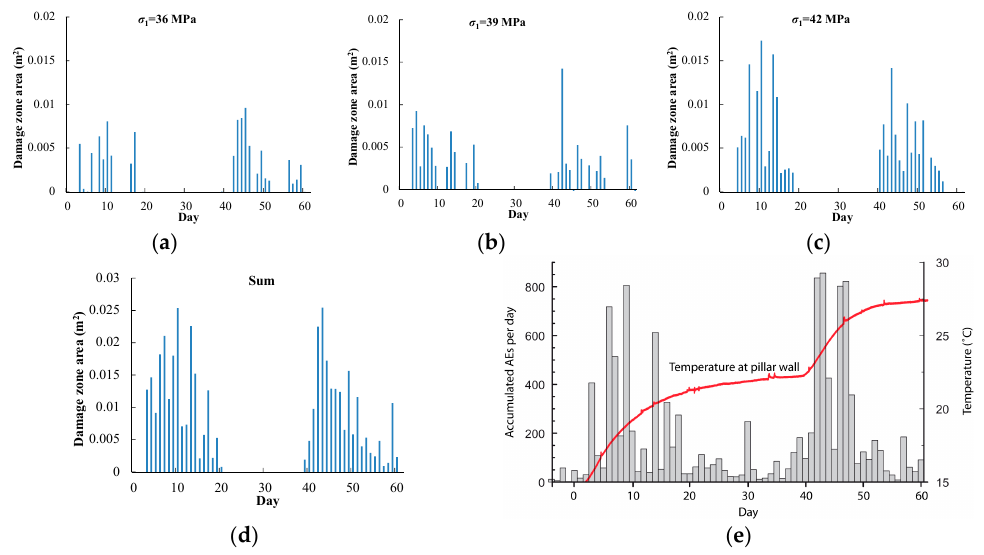
σ σ σ = 36 MPa; ( b ) 1 = 39 MPa; ( c ) 1 = 42 MPa;